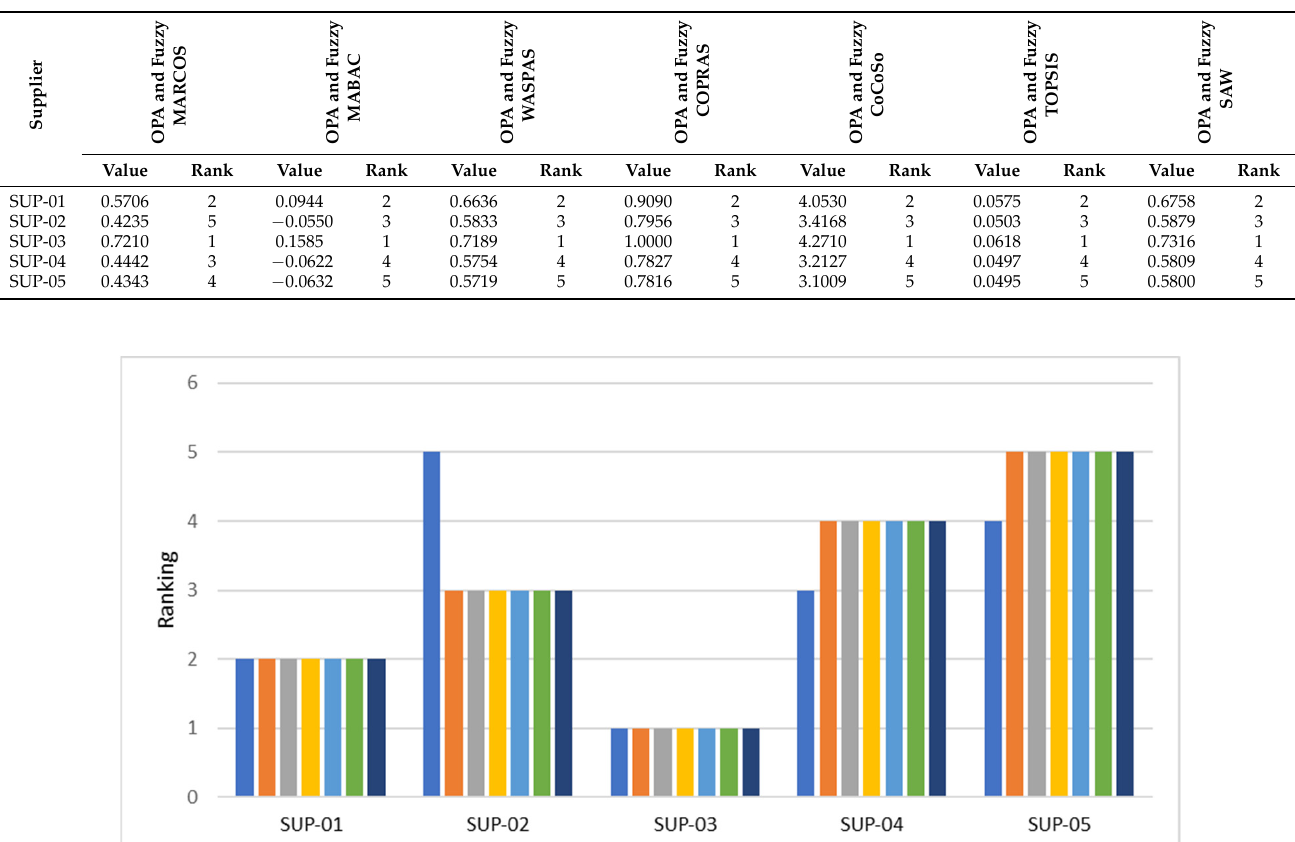
Table 12. Results of the comparative analysis of MCDM methods.